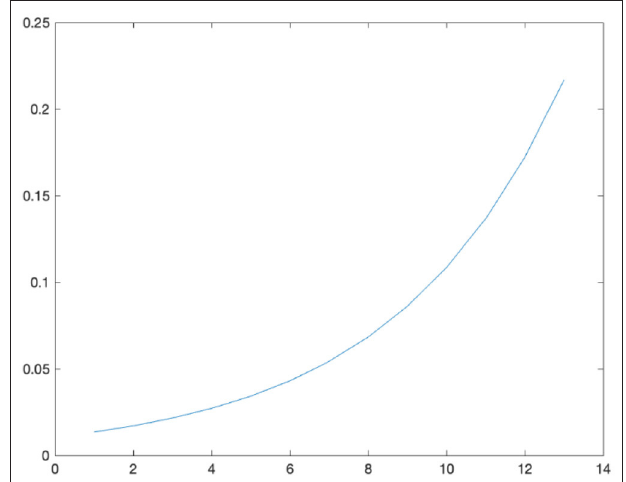
FIGURE 3 | The variation of the window weight